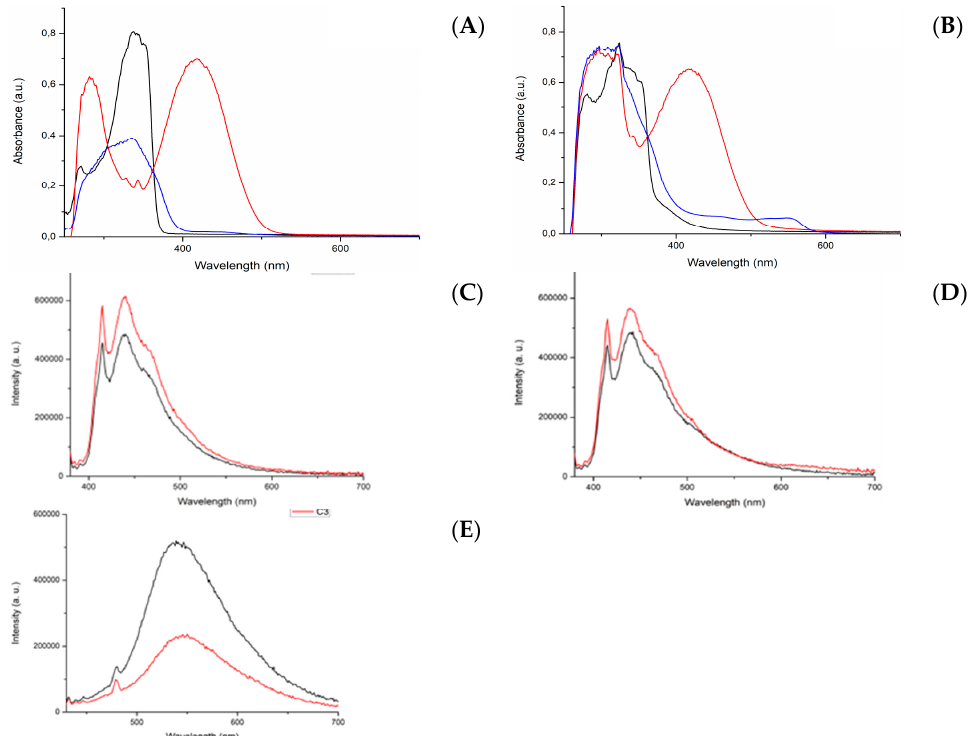
Figure 4. Absorption spectra recorded in DMSO at 100 µ M of: ( A ) L1 (black line), L2 (blue line), and L3 (red line); ( B ) C1 (black line), C2 (blue line), and C3 (red line). Emission spectra in DMSO at 10 µ M of: ( C ) L1 (black line) and C1 (red line), with λ ex = 370 nm; ( D ) L2 (black line) and C2 (red line), with λ ex = 370 nm; and ( E ) L3 (black line) and C3 (red line), with λ ex = 418 nm.